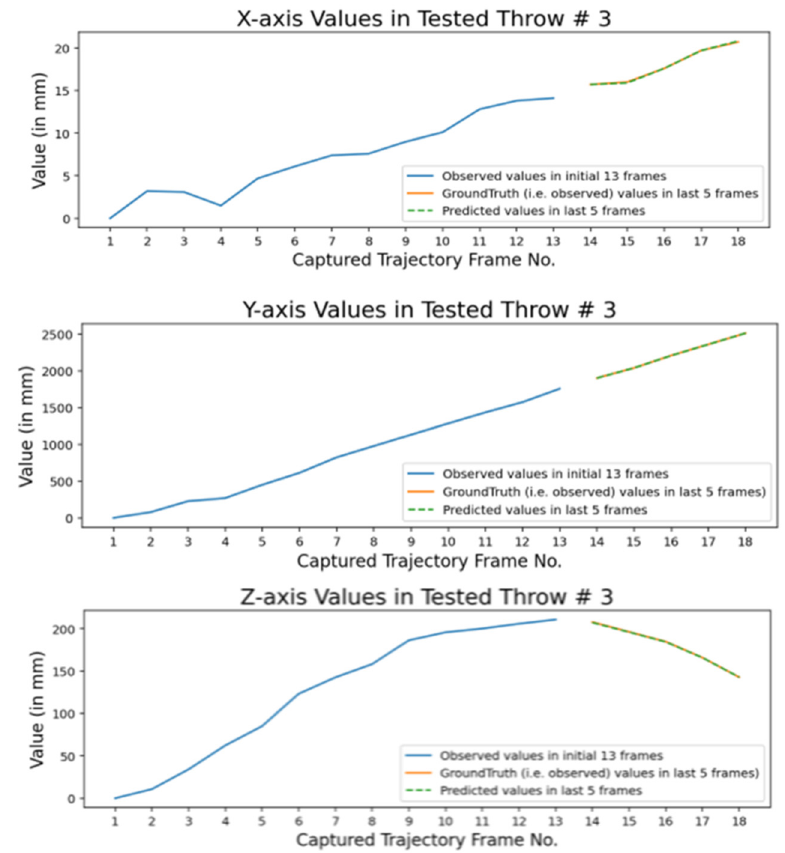
Figure 18. Comparison among predicted and ground truth values in a tested simulated throw.